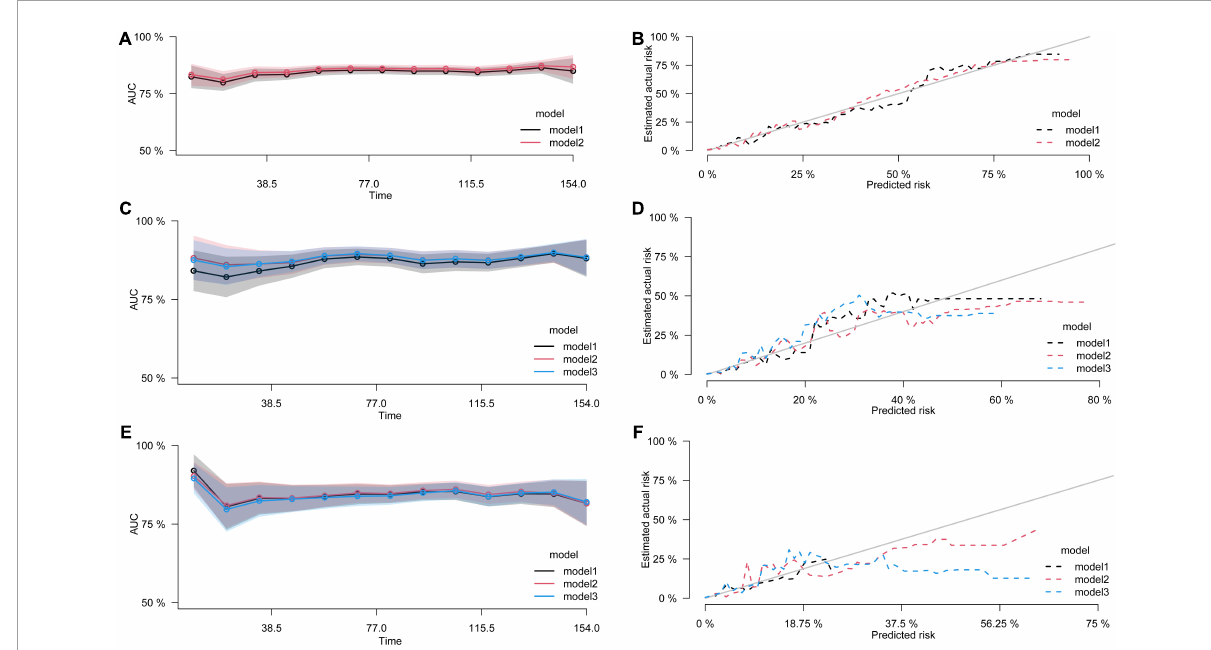
FIGURE2 The discrimination and calibration curves of predict models. (A,B) All-cause mortality; (C,D) cardiovascular mortality; (E,F) malignancies-specific mortality. The ribbons indicate the 95% CIs of AUC.